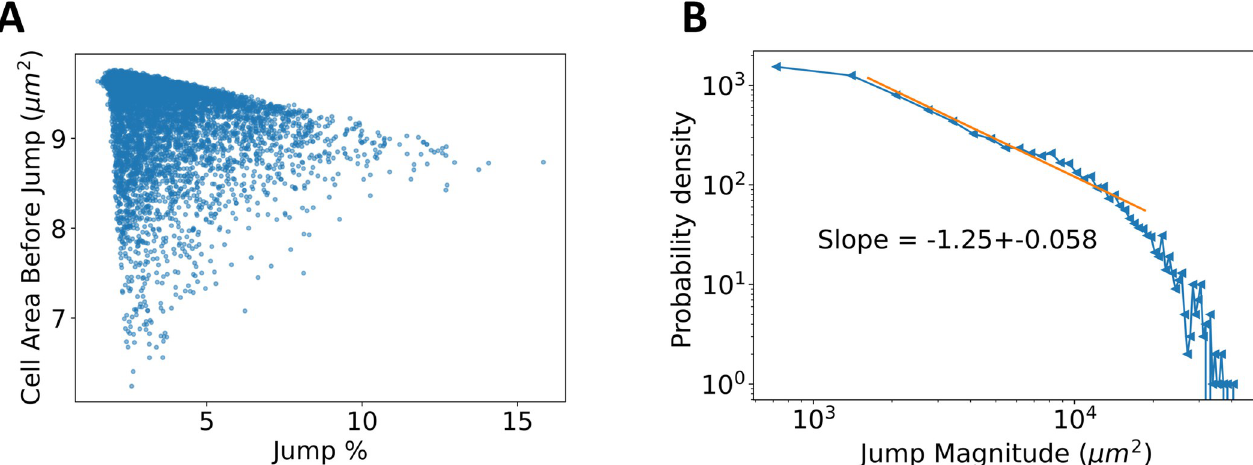
Fig 5. Avalanche Characteristics. A: Average cell area versus avalanche magnitude. The avalanche magnitude is quantified as the percent discontinuity in the total area. The more tightly packed the epithelium, right before the onset of the avalanche, the larger the total area discontinuity. B: Log-log plot of probability density of avalanche magnitudes. The functional form supports the presence of an underlying power law distribution, with a fit shown by the orange line. The exponent found is τ = 1.25 ± 0.06. Such power law distributions are a universal characteristic of avalanches found in nature.